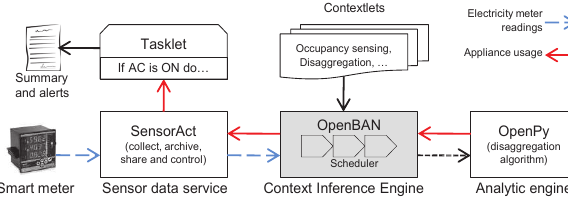
Figure 4: Deployment setup of SensorAct and OpenBAN systems for energy disaggregation application. possibly be stored under their Dropbox account. Using the integrated visualization tool, the user can also plot the